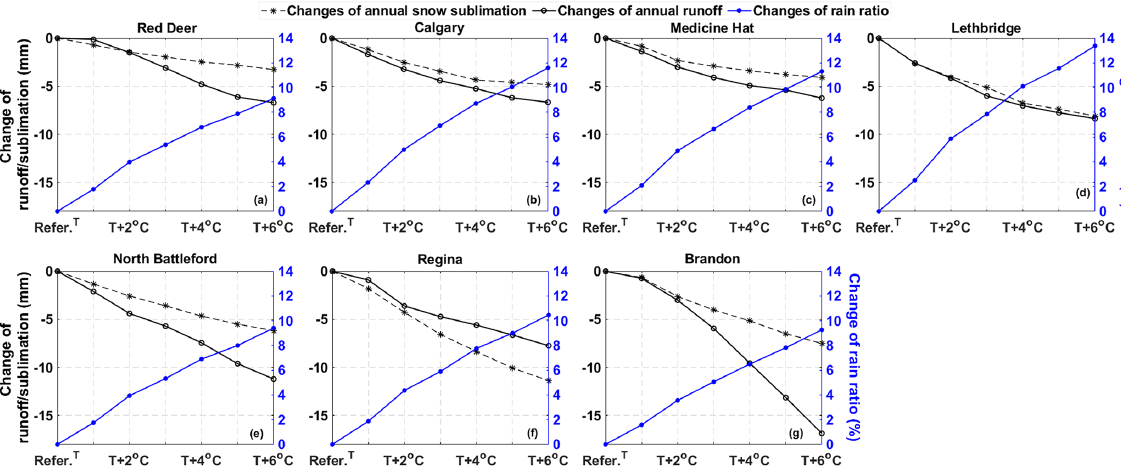
Figure 10. Change in runoff (mm), annual blowing snow sublimation (mm) and change in the ratio of rain in annual precipitation (%) for each climate (annual blowing snow sublimation and ratio of rain as in Fig.